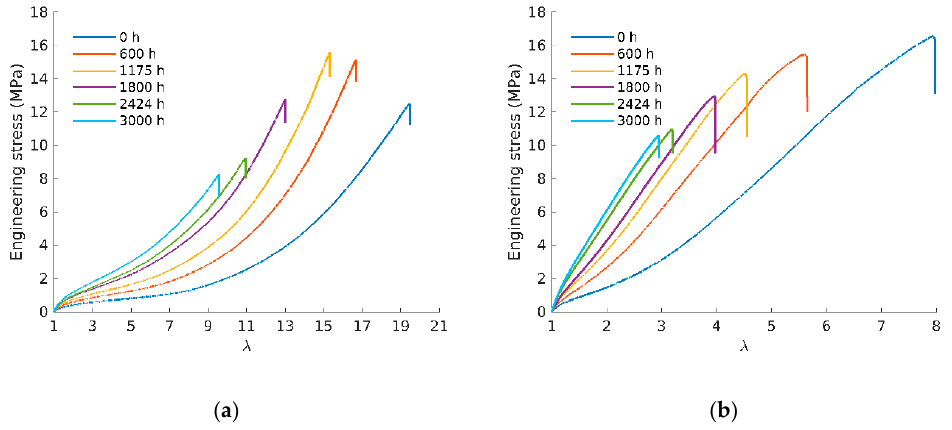
◦ C for unfilled and ( b ) filled